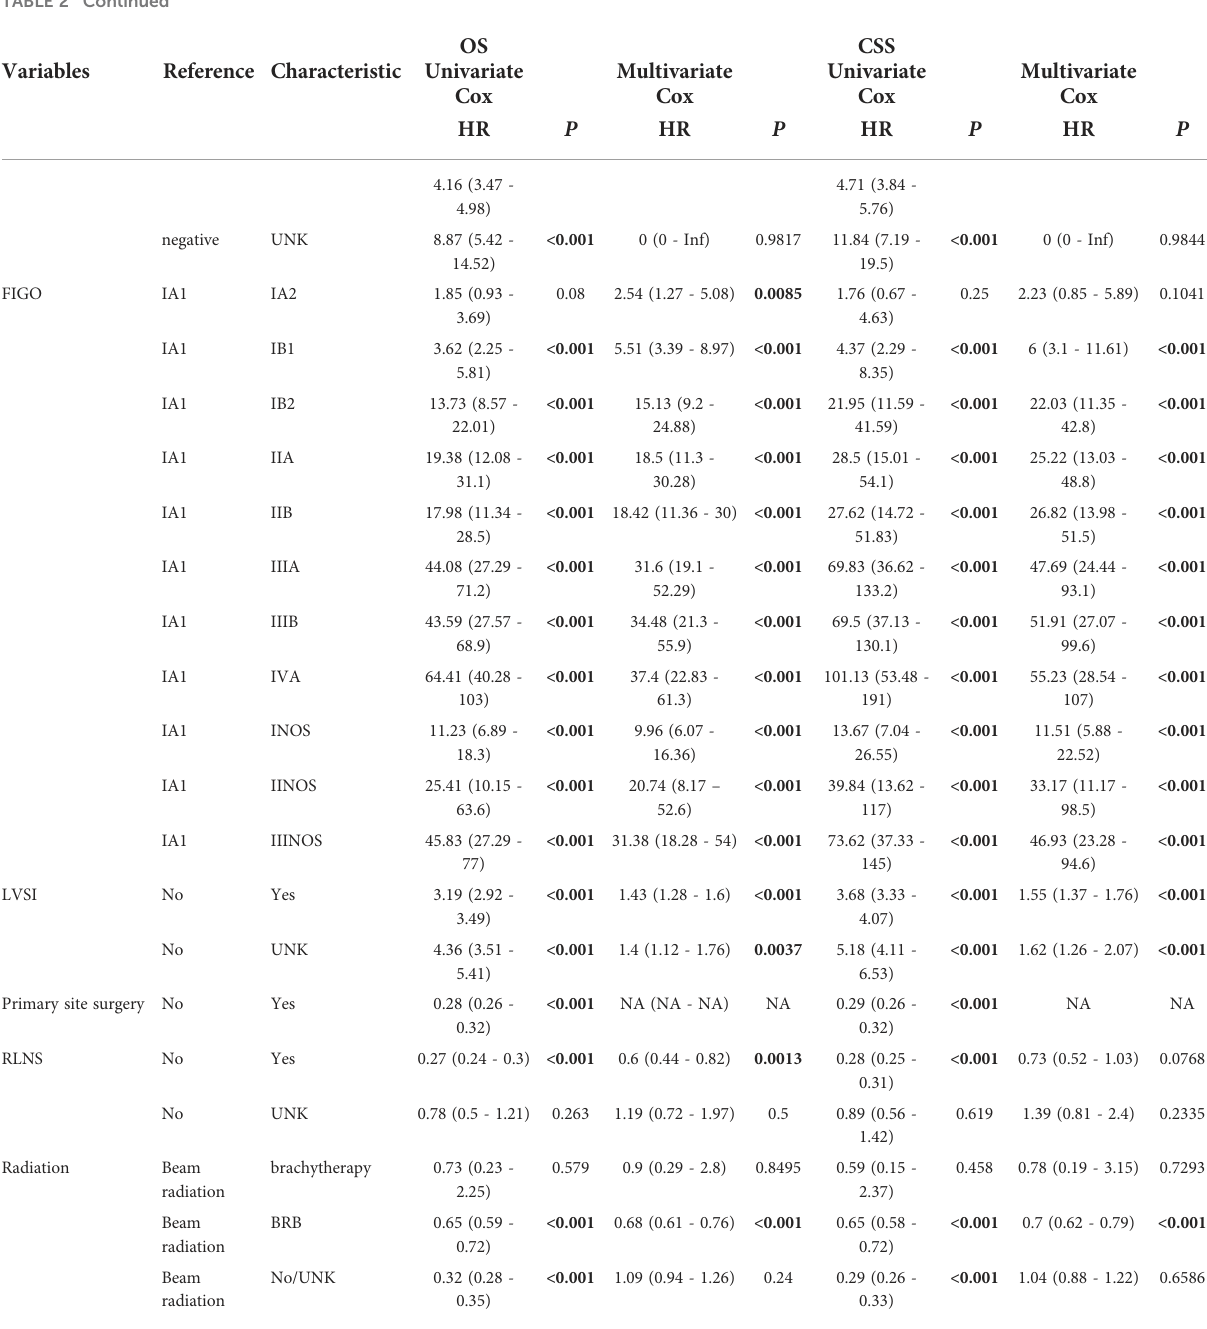
HR, hazard Ratio; CI, con fi dence interval; P<0.05 is marked with bold black. NA, not